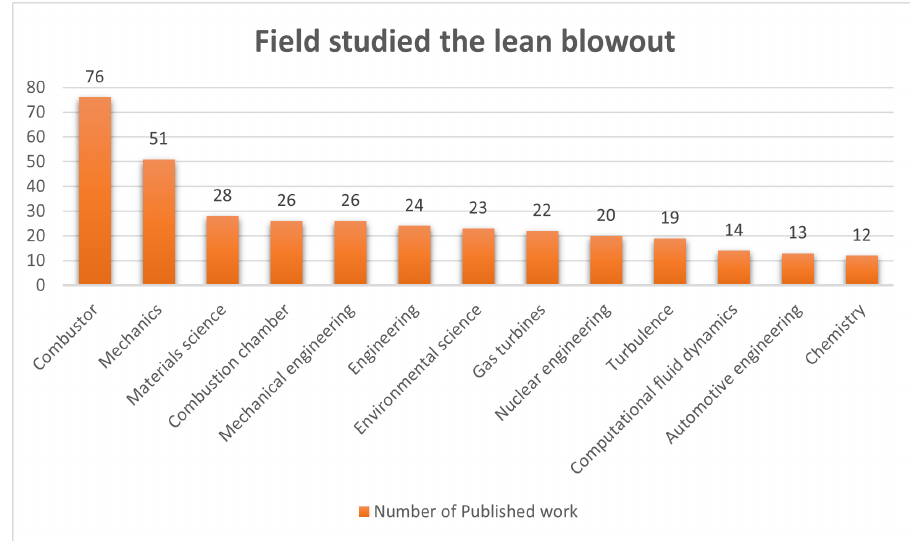
Figure 2. The fields studied the phenomenon of